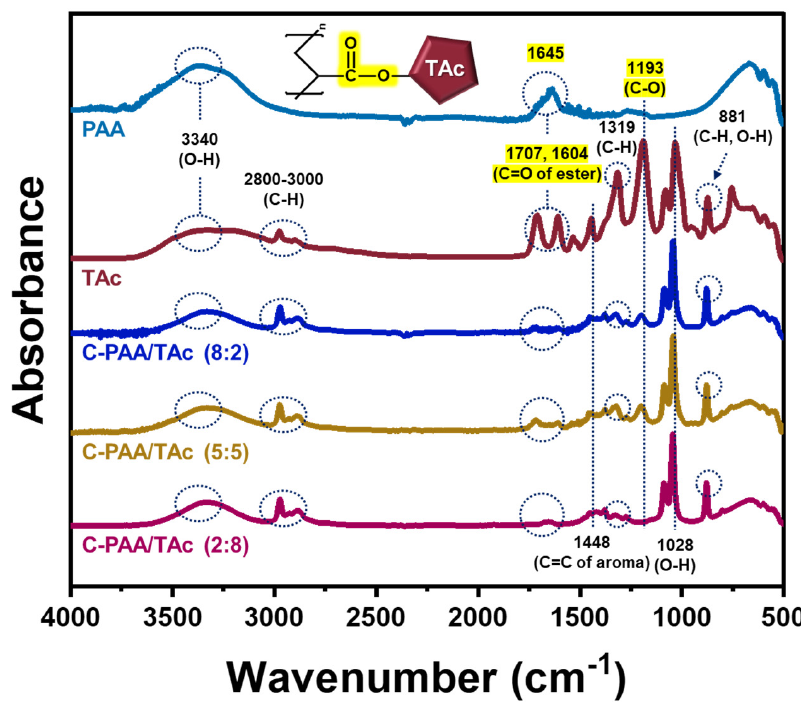
Figure 2. FT-IR spectra of PAA, TAc, C-PAA/TAc (8:2), C-PAA/TAc (5:5), and C-PAA/TAc (2:8). FT-IR spectroscopic analysis in the 500–4000 cm − 1 region revealed the characteristic bands for PAA, TAc, C-PAA/TAc (8:2), C-PAA/TAc (5:5), and C-PAA/TAc (2:8); the results